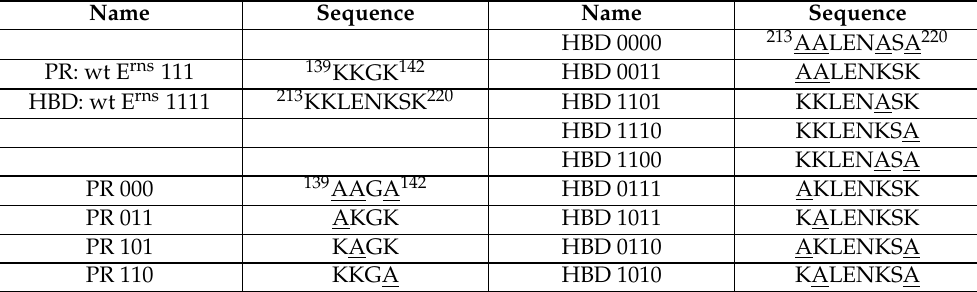
Table 1. Description of the E rns mutants applied in the study. Various mutants of the two potential heparin-binding sites, 139 KKGK 142 (termed “positive region”, PR; numbering according to Figure 1) and 213 KKLENKSK 220 (termed “heparin-bind- ing domain”, HBD), were generated by substitution of positively charged lysines (K) with neutral alanines (A). In addition to the full mutants ( 139 AAGA 142 and 213 AALENASA 220 ) with all lysines changed, single or double site-mutants were con- structed. To distinguish all these PR- (left columns) and HBD- (right columns) mutants, a code of 1 for lysine and 0 for alanine was used in the names of each of the corresponding mutant (sites mutated are underlined in the sequence).